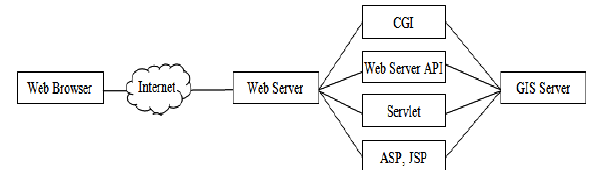
Figure 1: Thin client architecture (adapted from Alesheikh et al. , 2002)